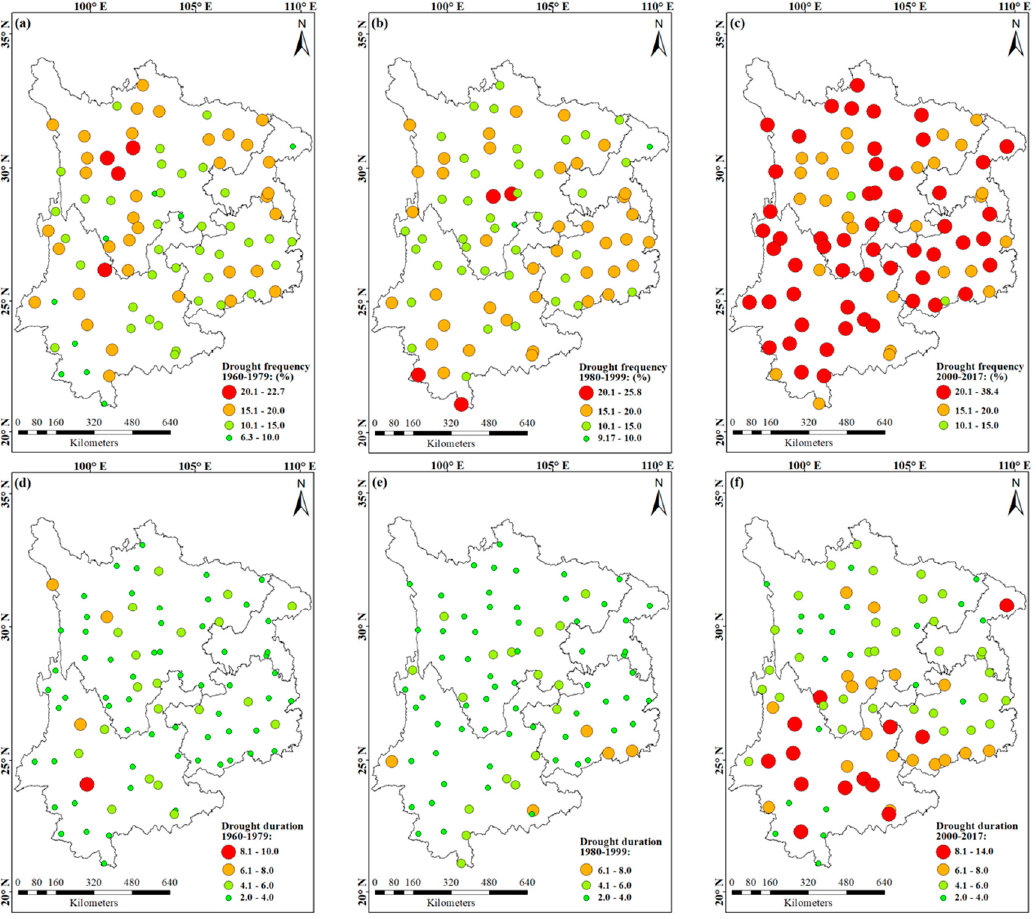
Figure 4. Map of drought frequency ( a – c ) and duration ( d – f ) over Southwest China for the